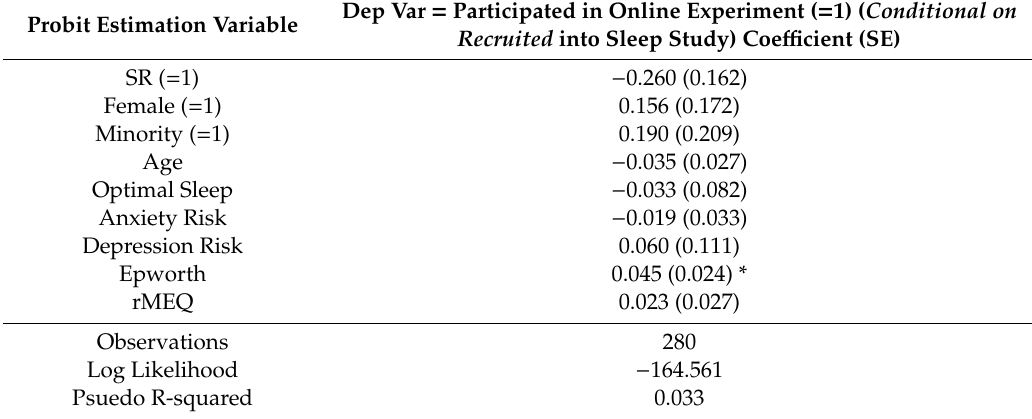
Table A1. Selection Equation Probit model.